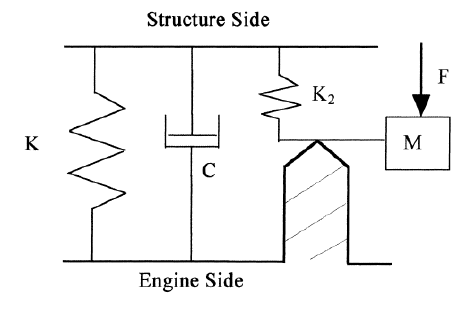
Fig. 8. Mechanical model of the active hydraulic mount [33].